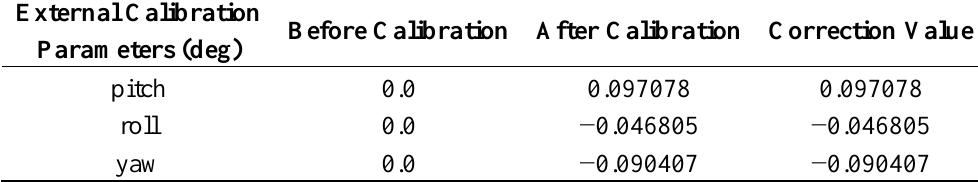
Table 3. External calibration parameter values before and after the calibration of the ZY1-02C panchromatic camera.